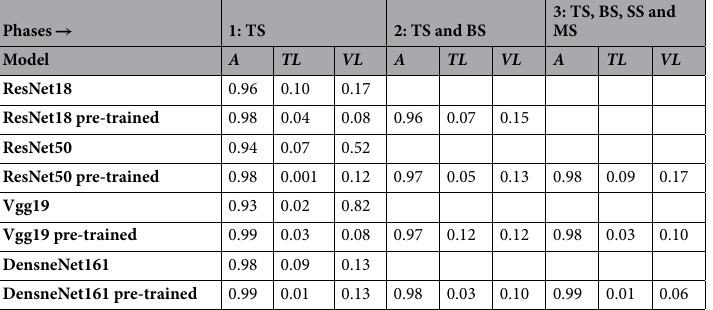
Table 6. Accuracy ( A ), train loss ( TL ) and validation loss ( VL ) of the best epoch obtained in the training process for each of the CNN models and for each phase (TS, BS, SS and MS correspond to top, bottom, side and middle sealing, respectively).